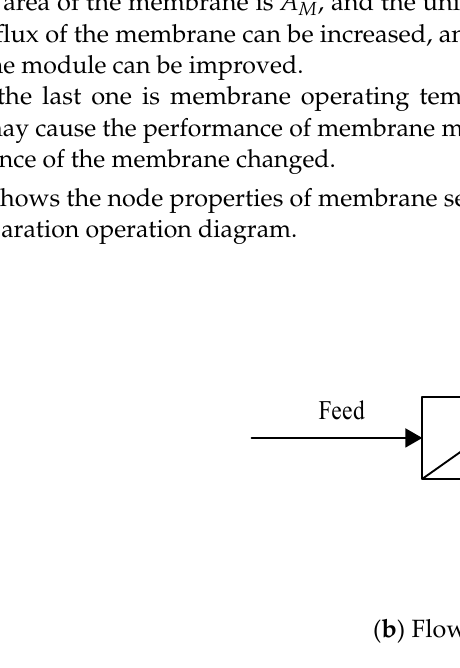
Figure 2. Membrane node graph ( a ) and membrane module flow chart ( b ) obtained by decoding.